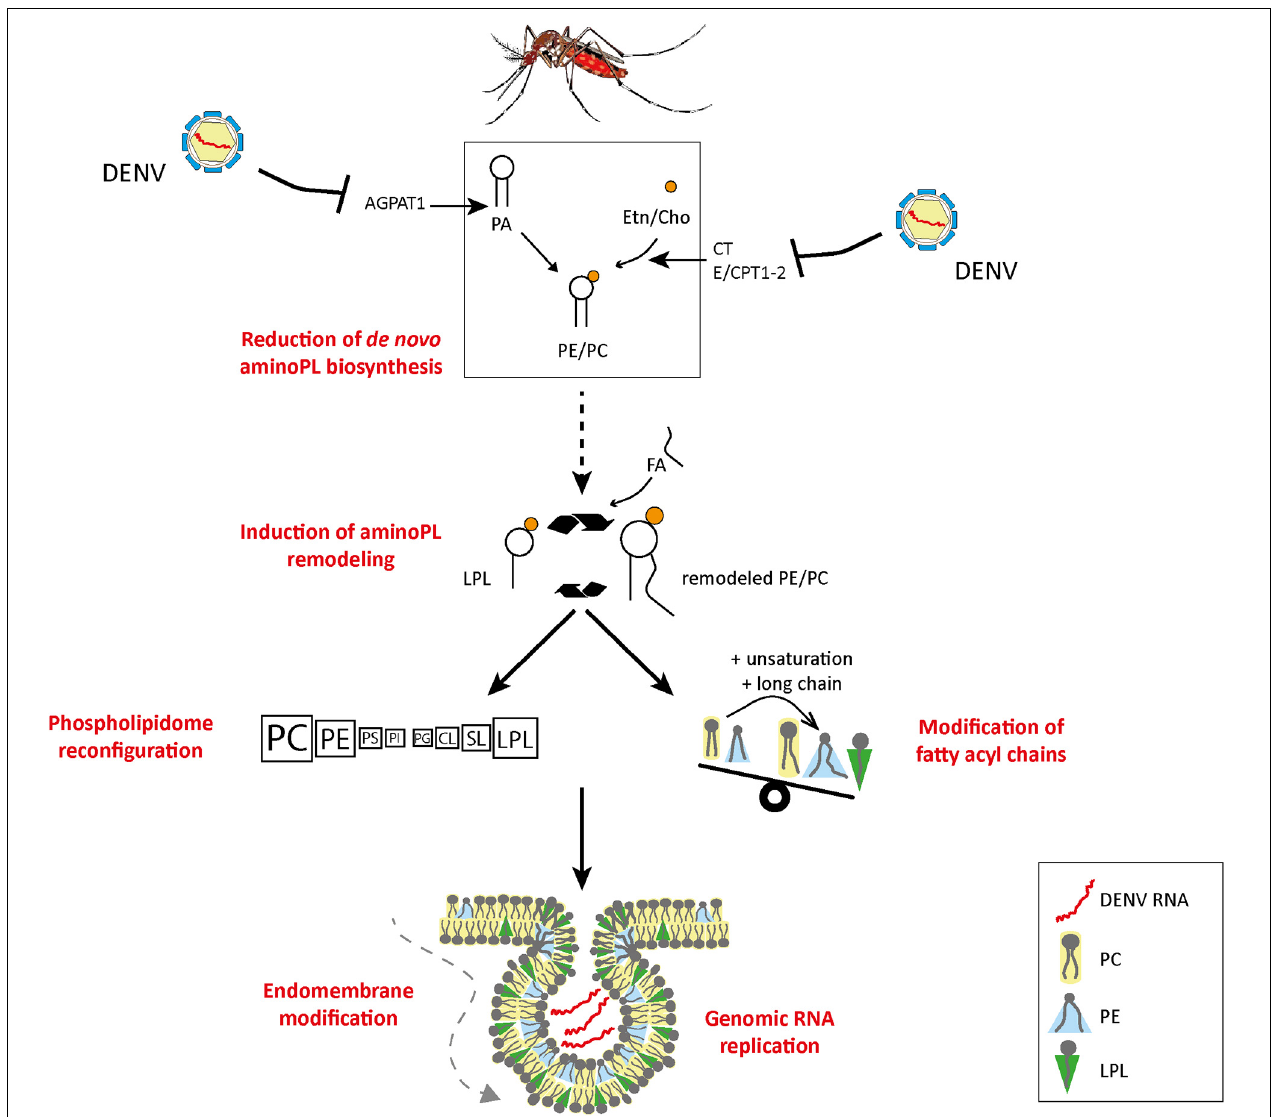
FIGURE 9 | Model of DENV-induced phospholipid reconfiguration for viral replication. We propose that flaviviruses reconfigure PLs by inhibiting de novo PL biosynthesis via enzyme regulation and by inducing PL remodeling to enable the formation of replication complexes. AGPAT, 1-acyl-sn-glycerol-3-phosphate O-acyltransferases; CT, triphosphate:phosphocholine cytidylyltransferase; E/CPT1-2, DAG:CDP-ethanolamine/choline ethanolamine/cholinephosphotransferase; PC, phosphatidylcholine; PE, phosphatidylethanolamine; PS, phosphatidylserine; PI, phosphatidylinositol; PG, phosphatidylglycerol; CL, cardiolipin; SL, sphingolipid; LPL, lysophospholipid; FA, fatty acid; Etn, ethanolamine; Cho, choline; AminoPL,